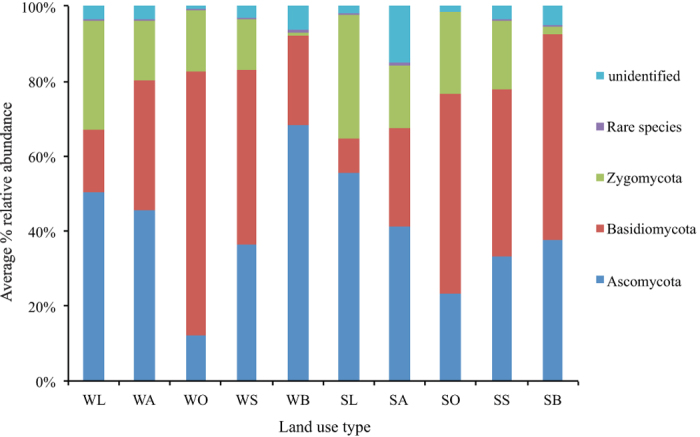
The relative abundances of major taxonomic groups at the phylum level for fungi across five land-use types in winter and summer.The land use types and their abbreviations are: oak forest (SO and WO), oriental arborvitae forest (SA and WA), black locust plantation (SL and WL), shrub land (SS and WS), and bare land (SB and WB) respectively. The figure is performed in R v.3.1.3 project (R Development Core Team. 2015), using the R packages vegan.